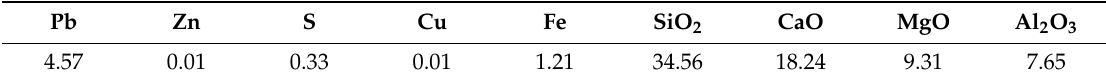
Table 2. Multi-element analysis results of ore / %.